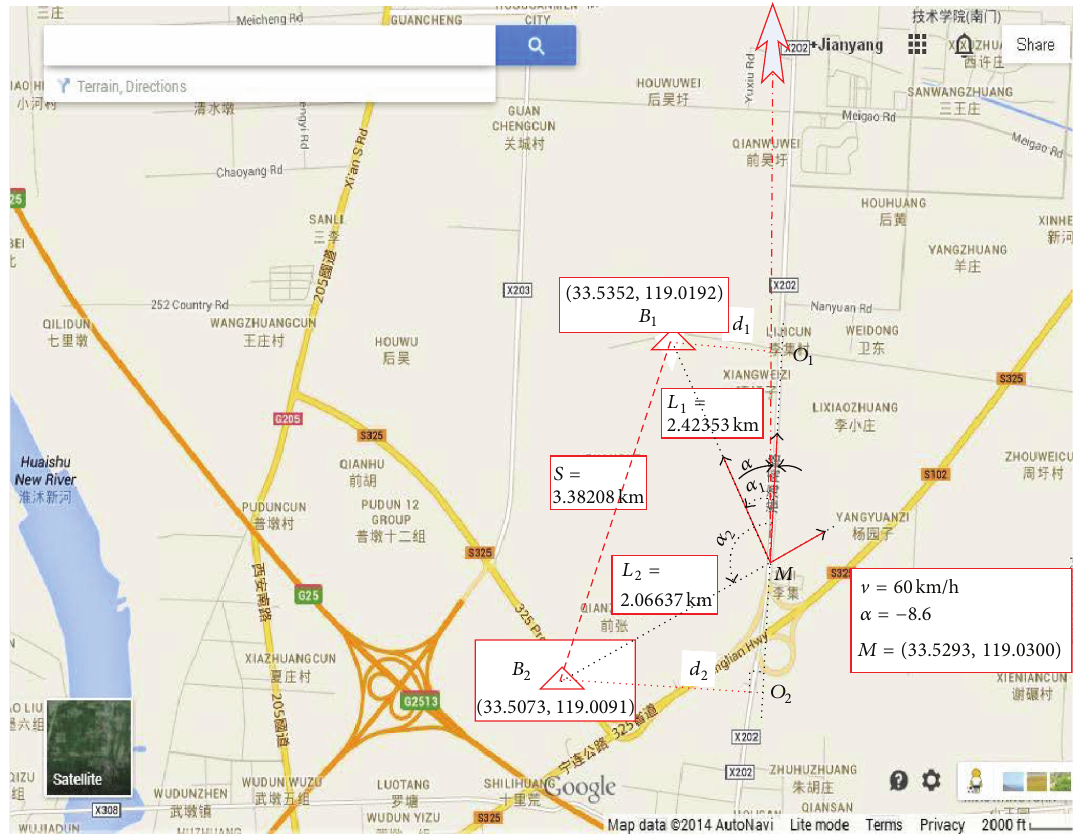
Figure 3: In-vehicle navigation showing with position